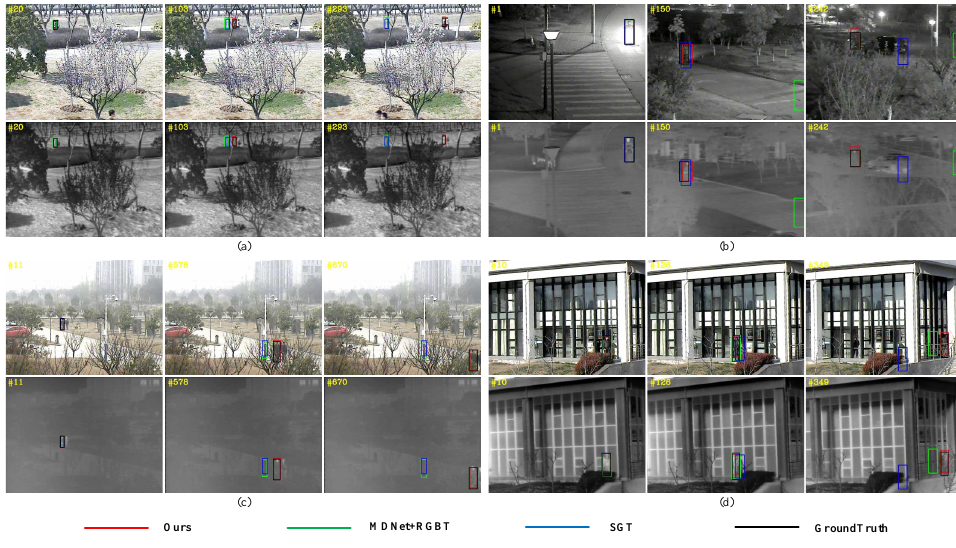
Figure 5. Qualitative performance against state-of-the-art RGB-T trackers on four video sequences. ( a ) diamond; ( b ) elecbike10; ( c ) fog; ( d )